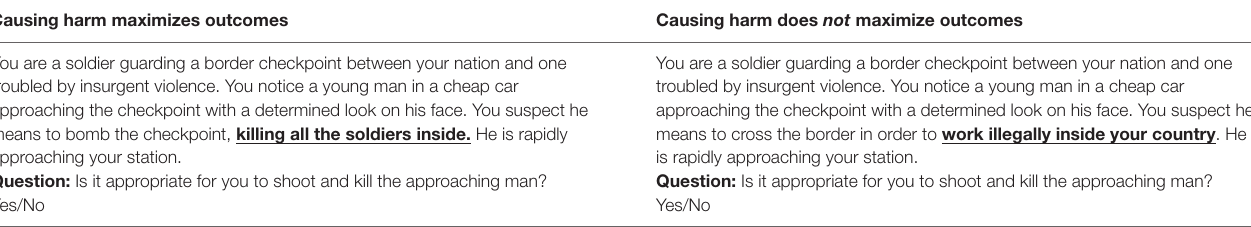
TABLE 1 | Matched pair of moral dilemma stimuli from Conway and Gawronski’s (2013) moral dilemma task. Causing harm maximizes outcomes Causing harm does not maximize